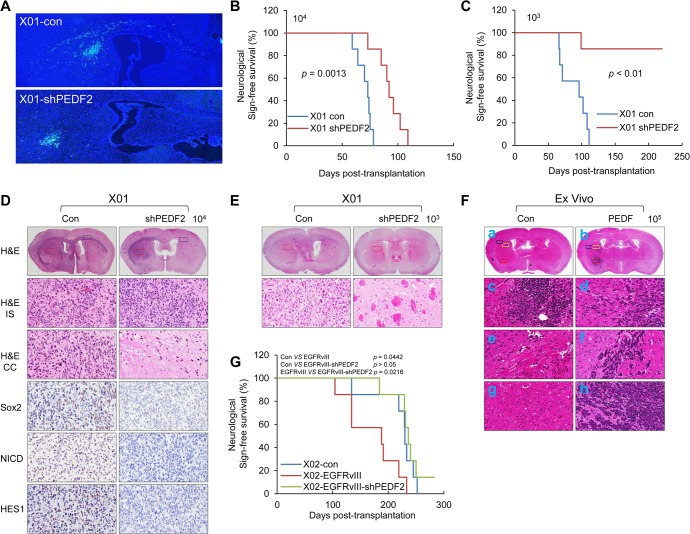
PEDF promotes tumor progression of GSCs.(A) A free-floating assay of mouse brain was injected with X01-Con cells (upper) or X01-shPEDF2 cells (bottom). These cells were labeled by GFP (green). Nuclei were counterstained with Hoechst (blue). All images were taken at 5x magnification. (B, C) Kaplan-Meier survival curves of mouse implanted with 1 x 104 cells (B; p = 0.0013) and 1 x 103 cells (C; p < 0.01) infected with shPEDF2-expressing lentiviral or control construct. (D) Histopathology of Balb-c/nu mouse brain, orthotopically injected with 1 x 104 of X01-Con cells (left) or X01-shPEDF2 cells (right). Upper panel is H&E staining of the whole brain. Red box indicates an injection site and H&E (IS). This site was stained by Sox2, NICD, and HES1. Blue box indicates a site of corpus callosum far from injection site and H&E (CC). All images were taken at 40x magnification. (E) Histopathology of Balb-c/nu mouse brain, orthotopically injected with 1 x 103 X01-Con cells (left) or X01-shPEDF2 cells (right). Upper panel is H&E staining of the whole brain. Red box indicates an injection site and H&E staining (bottom); all images were taken at 40x magnification. (F) H&E staining of mouse brain, orthotopically injected with 1 x 105 Ex Vivo cells infected with PEDF-expressing lentiviral (right) or control construct (left). The upper panel is the whole brain (a, b). The yellow box indicates injection sites, caudate putamen (c, d). The blue box indicates corpus callosum (e, f). Red box indicates another caudate putamen that is a local site far from the injection site (g, h). All images were taken at 20x magnification. (G) Kaplan-Meier survival curves of mouse were implanted with X02-Con, X02-EGFRvIII, or X02-EGFRvIII-shPEDF2 cells (Control versus EGFRvIII; p = 0.0442, Control versus EGFRvIII-shPEDF2; p > 0.05, EGFRvIII versus EGFRvIII-shPEDF2; p = 0.0216).